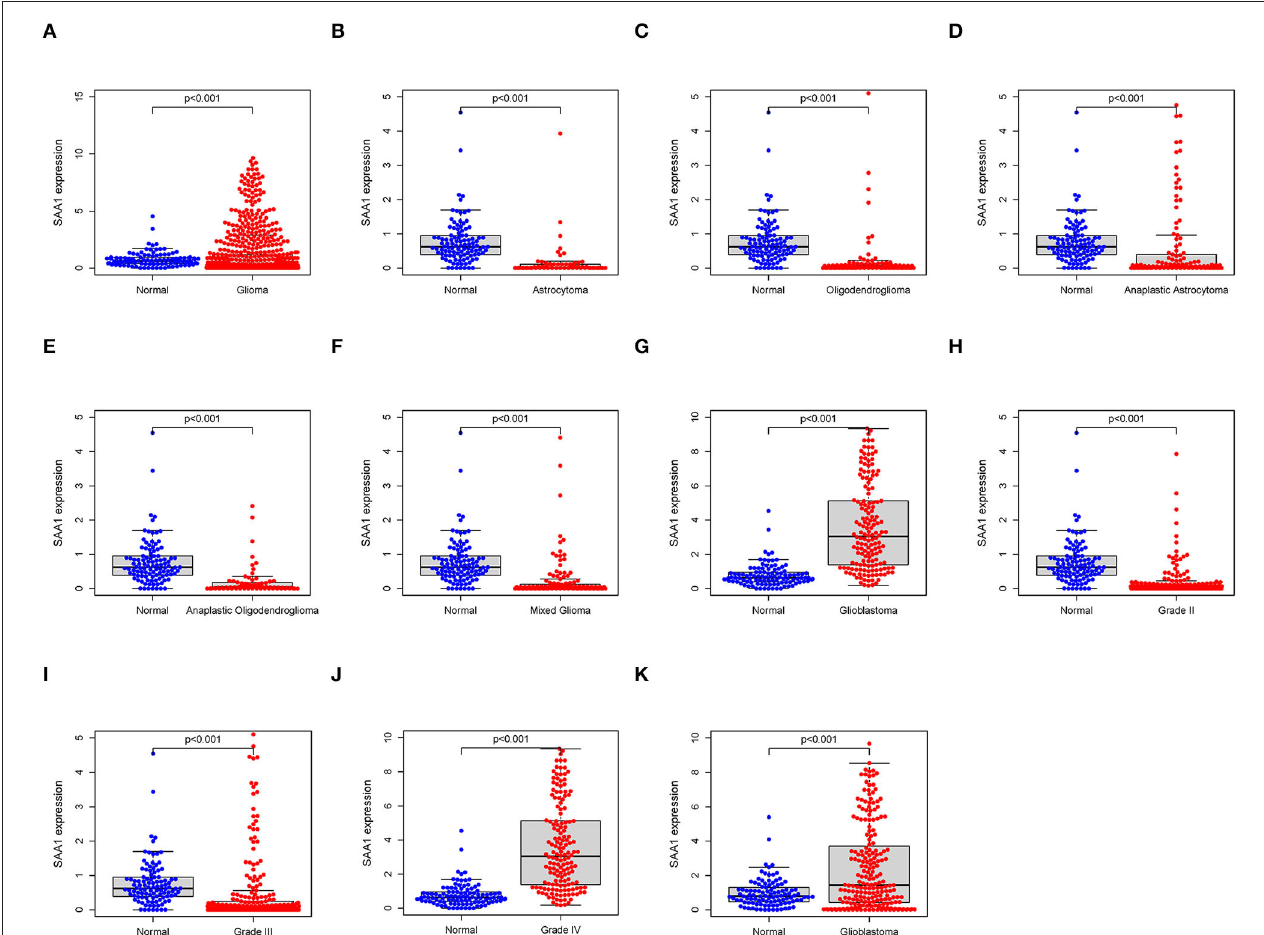
FIGURE 5 | Differential expression of SAA1 between normal and clinical characteristics. (A) Differential expression of SAA1 between normal and glioma samples. (B–G) Differential expression of SAA1 between normal and different subtypes of gliomas. (H–J) Differential expression of SAA1 between normal and different grade gliomas. (K) External validation of the differential expression of SAA1 between normal and GBM in the CGGA database.